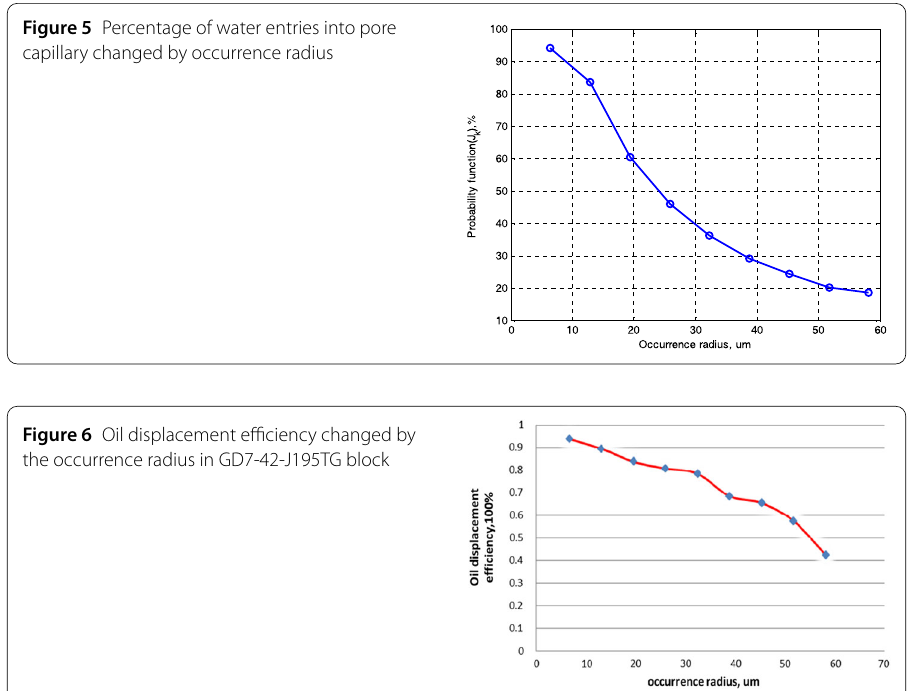
Figure 5 Percentage of water entries into pore capillary changed by occurrence radius